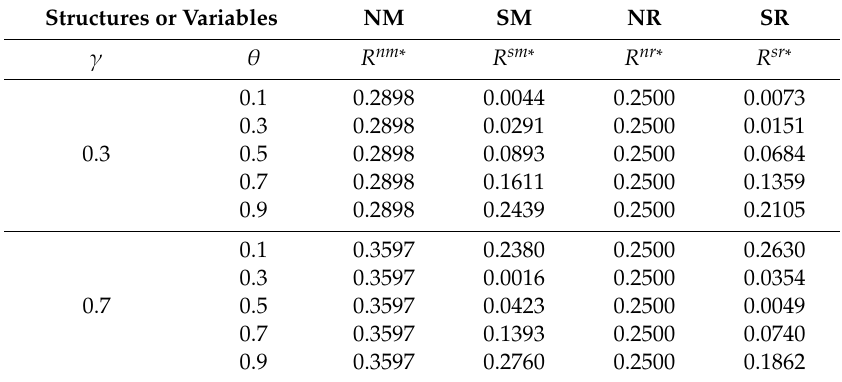
Table 7. The influence of sharing ratios on the profit of the retailer under four modes(Unit: USD). Structures or Variables